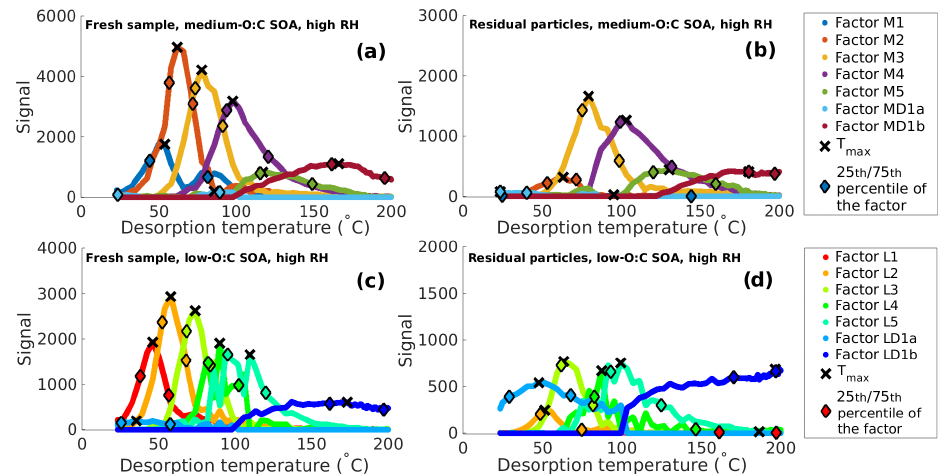
Figure 1. Main positive matrix factorization (PMF) mass loading profiles for the thermal desorption of secondary organic aerosol (SOA) from α -pinene at high relative humidity (RH) conditions. (a) Fresh sample of medium-O : C SOA. (b) Residual particles of medium-O : C SOA after 173–259min of evaporation in a residence time chamber (RTC; the RTC sample). (c) Fresh sample of low-O : C SOA. (d) Residual particles of low-O : C SOA after 168–254min of evaporation in the RTC (the RTC sample). Black crosses indicate the peak desorption temperature T max , and the diamonds mark the 25th and 75th percentiles of the area of each